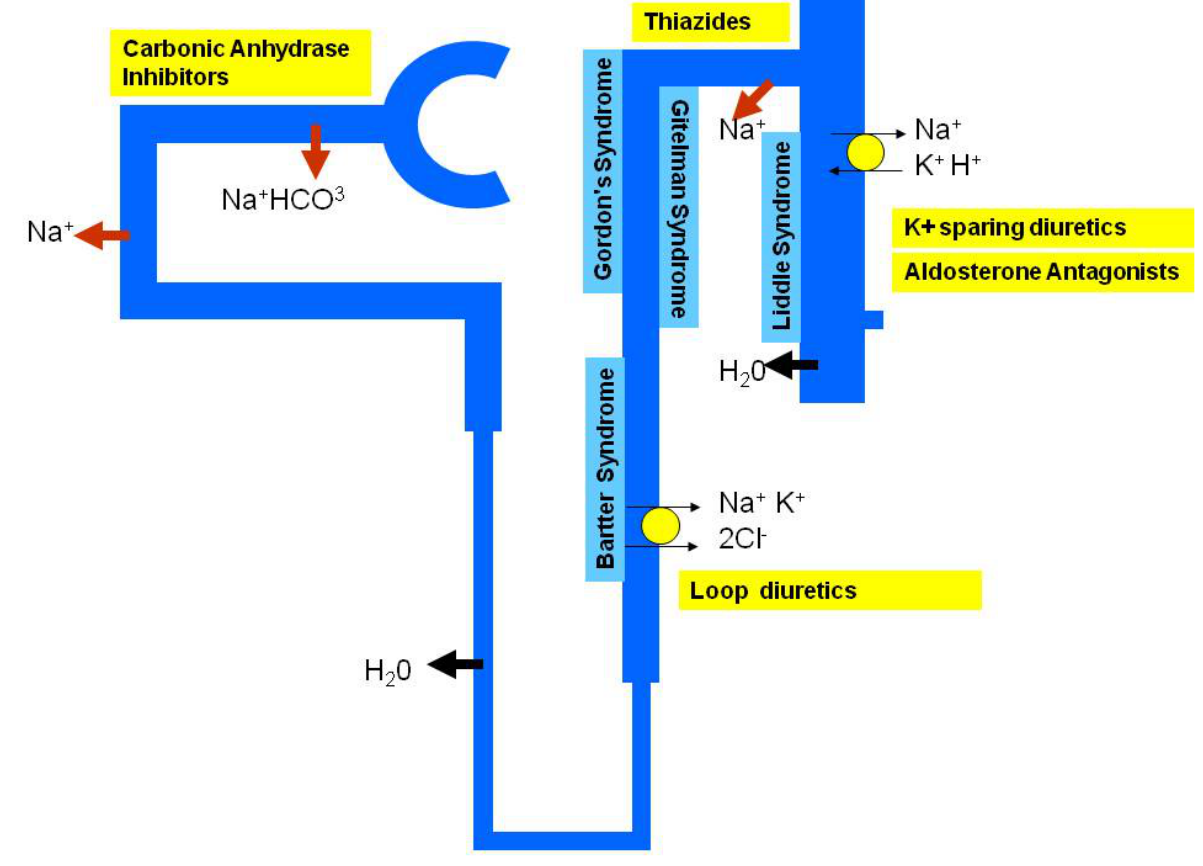
Figure 1. Schematic nephron showing sites of action of common diuretics and location of syndromes related to blood pressure